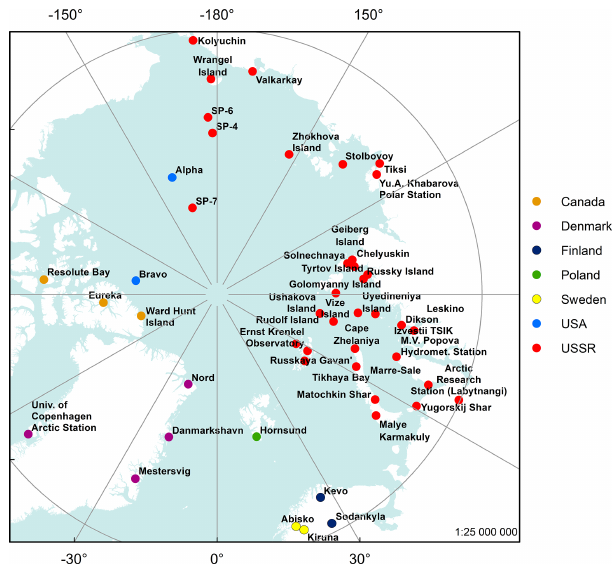
Figure 7. IGY Arctic research stations of the participating coun-